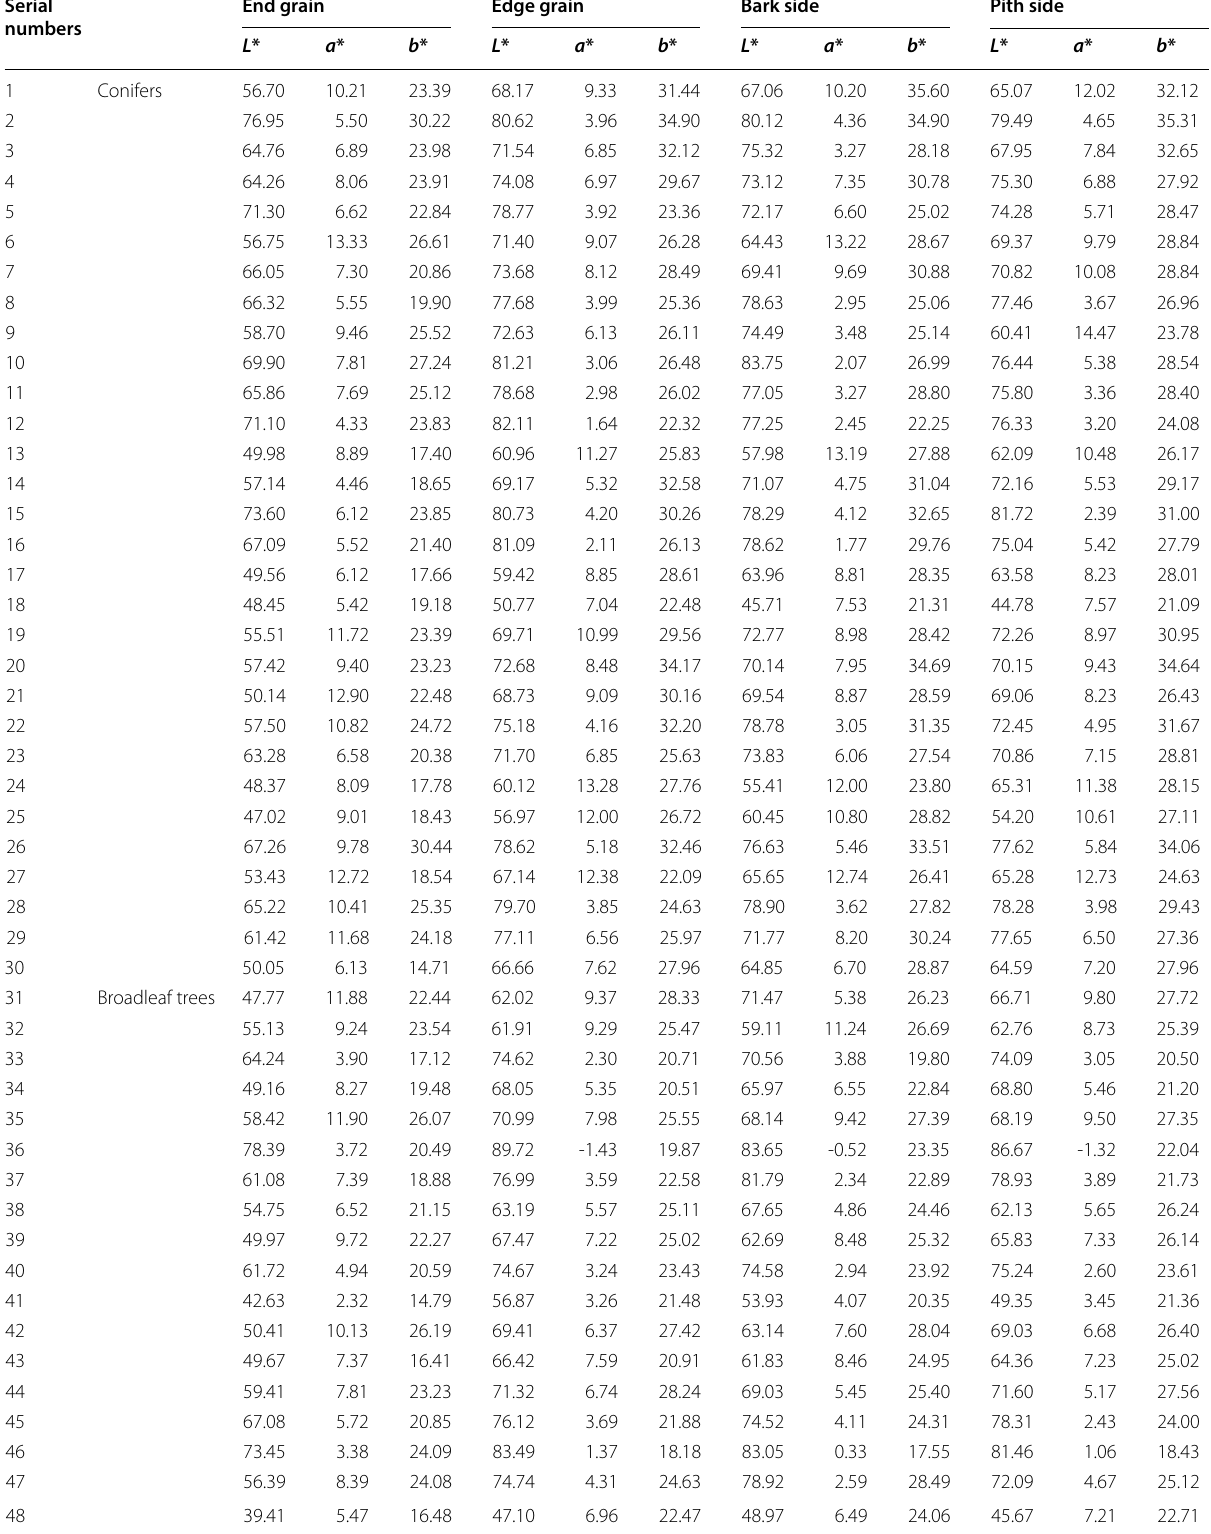
Table 3 Measured lightness L * and hue/saturation ( a *, b *) in L * a * b * color